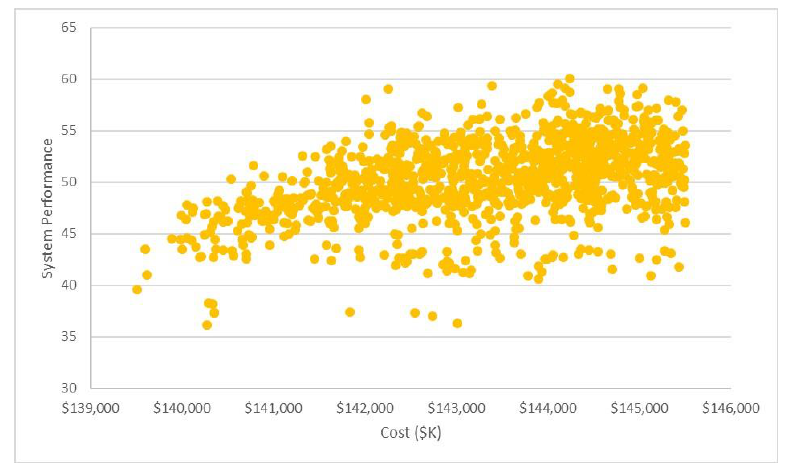
Figure 4. SBD Feasible Tradespace Created by Monte Carlo Simulation.